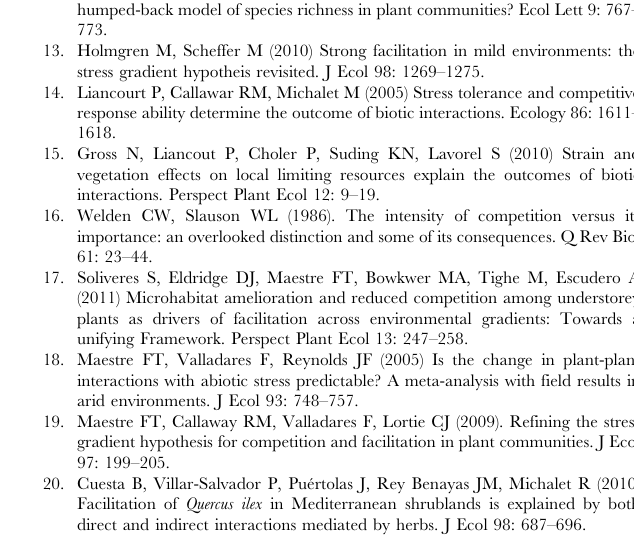
Table S1 Data matrices for the all species case. Table S2 Data matrices for the herb species case. Table S3 Data matrices for the shrub/cactus species case. Table S4 Data matrices for the shrub species only